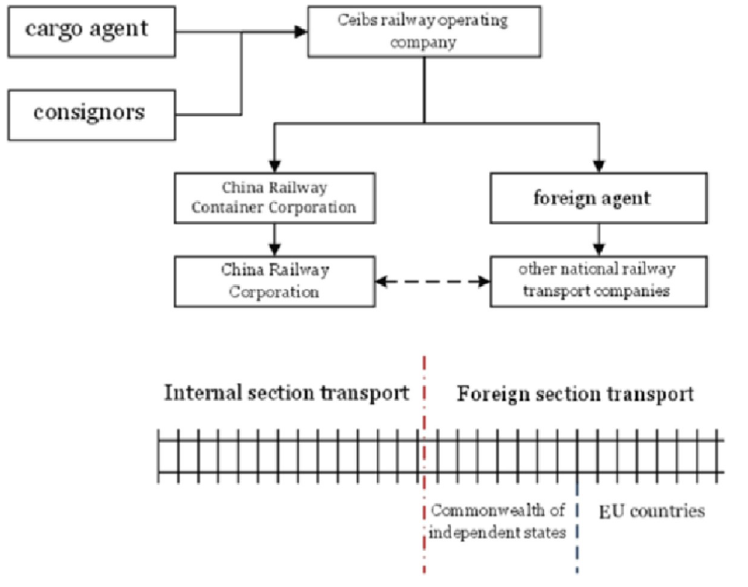
Fig 2. Major participants in the China Railway